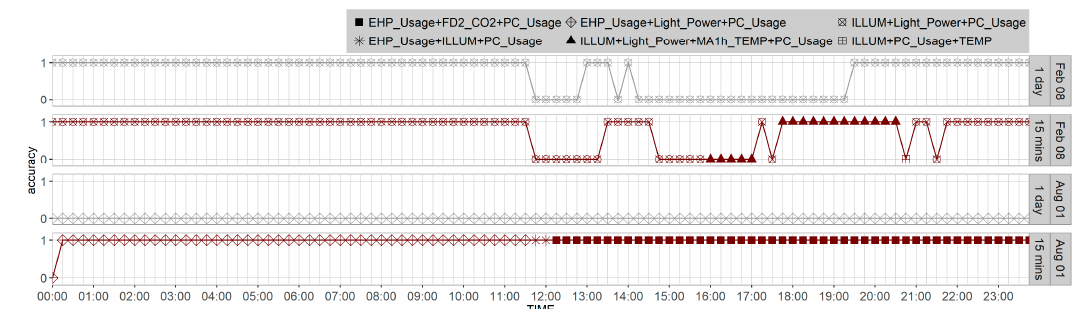
Figure 8. Comparison of estimation results and final selected classification models between 1-day and 15-minute window moving interval cases with the CART algorithm.